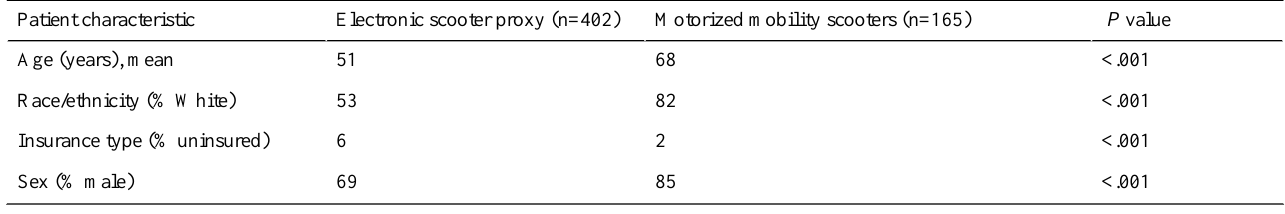
Table 1. Demographics for the electronic scooter rider proxy code V03.19 compared to motorized mobility scooter riders